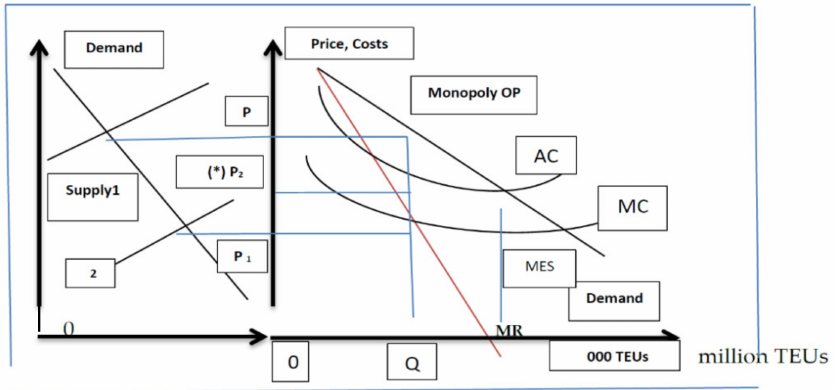
Figure 11. CM industry and firm in equilibrium? (*) Oligopoly tries to achieve price OP 2 , after pricing at OP 1 , using GRIs. Source: